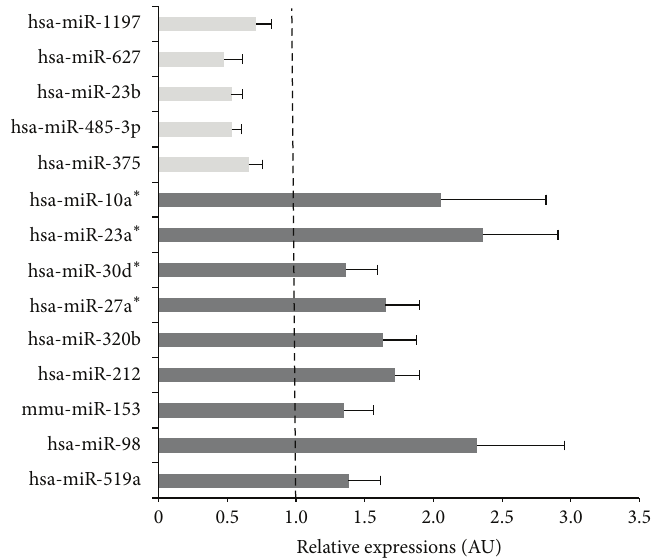
Figure 2: MiRNAs are regulated in human islet in response to glucose. miRNA regulations in human islets exposed to 16.7mM versus 5.5 mM for 24h (see Table 2). Data are expressed as mean of 3 biological replicates ± SEM. Each miRNA was normalized to the geometric mean of all miRNAs expressed in all